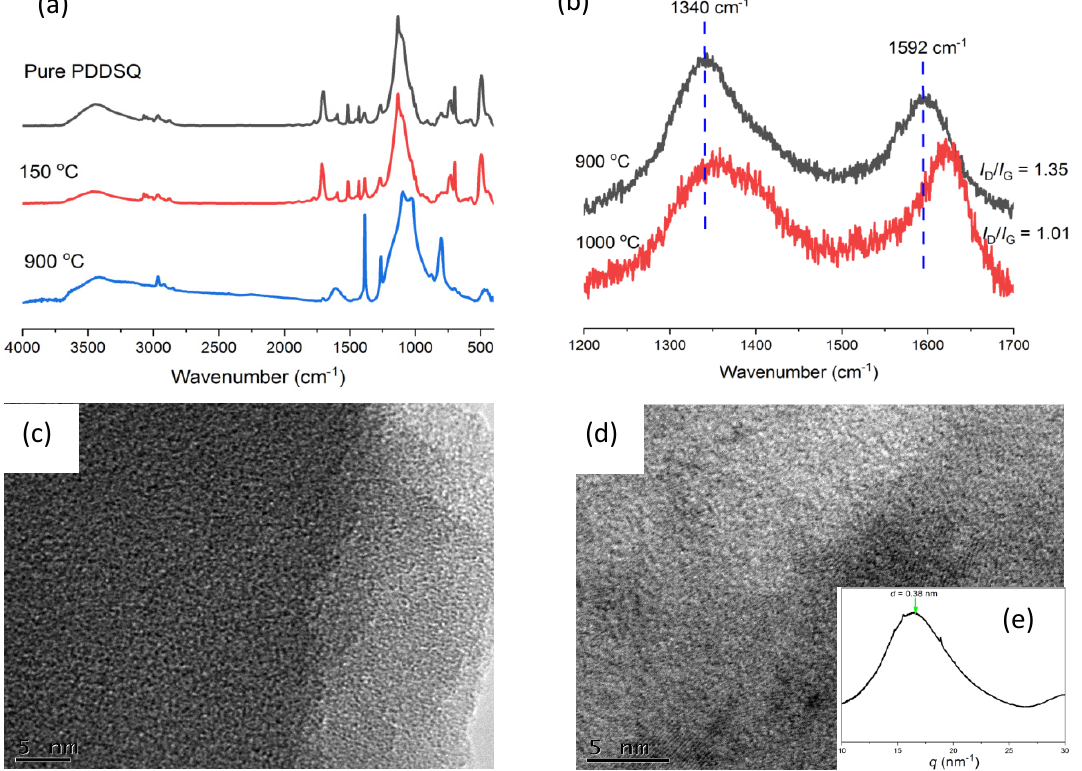
Figure 7. ( a ) FTIR spectra of pure PDDSQ before thermal treatment and after thermal curing at 150 and 900 °C. ( b ) Raman spectra of pure PDDSQ after thermal treatment at 900 and 1000 °C. ( c , d ) TEM images of pure PDDSQ after thermal treatment at ( c ) 900 and ( d ) 1000 °C. ( e ) corresponding WAXD pattern after thermal treatment at 1000 °C.